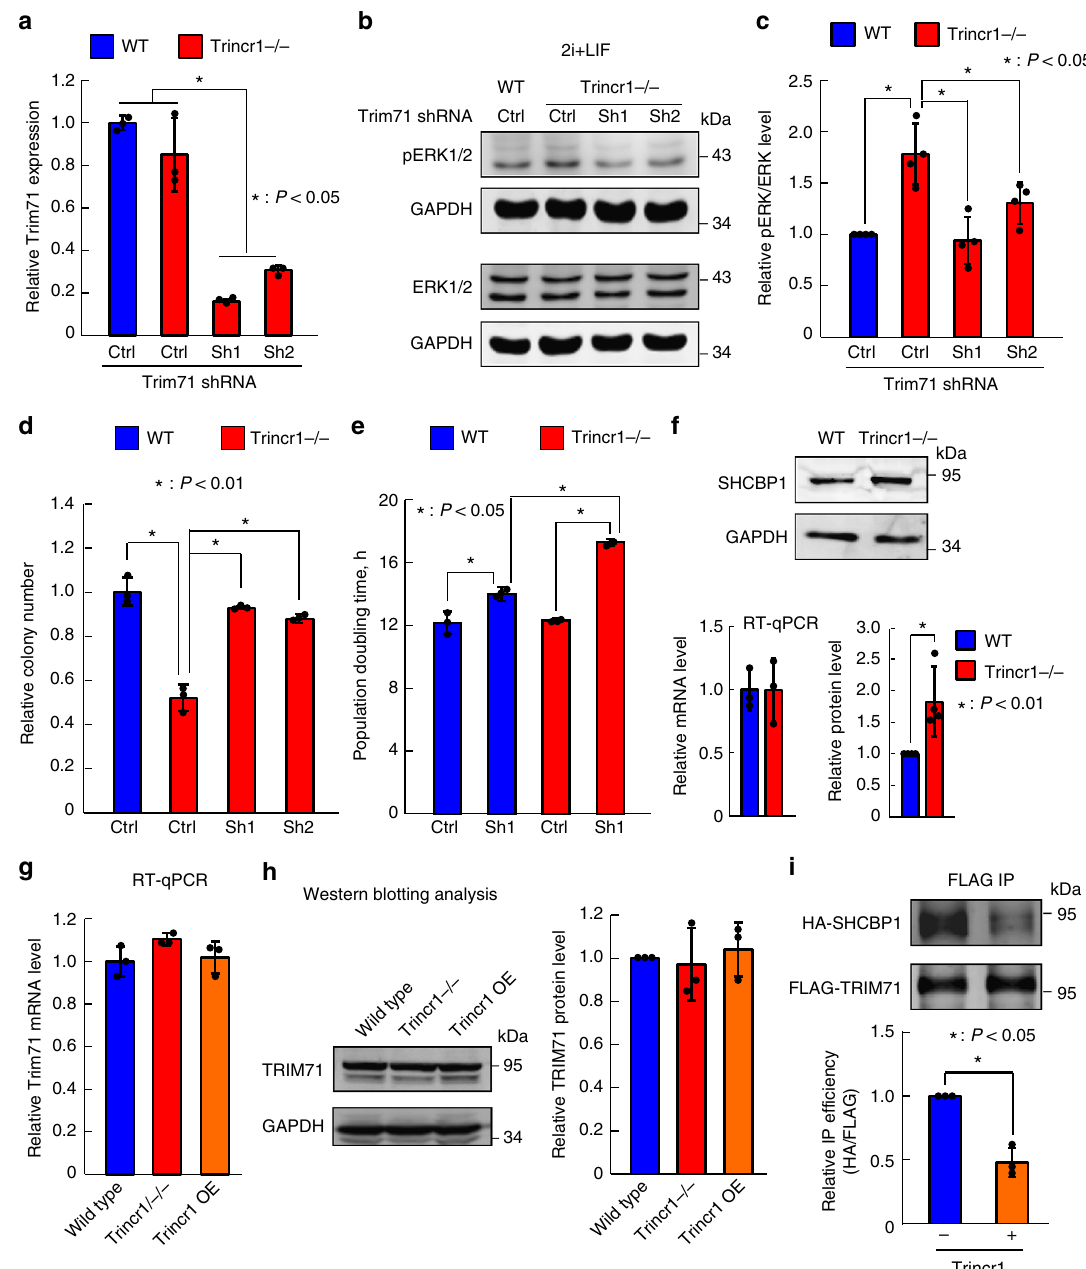
Fig. 6 Trincr1 functions through suppressing TRIM71. a RT-qPCR analysis of Trim71 knocking down in Trincr1 − / − ESCs. n = 3 biological replicates. b Western blotting analysis of pERK in control shRNA vector treated wild-type ESCs and control or Trim71 shRNA vector treated Trincr1 − / − ESCs cultured in 2i + LIF. Shown are representative images. c Quanti fi cation of pERK/ERK. n = 4 independent experiments. d Colony formation assay for control or Trim71 shRNA ESCs in wild type or Trincr1 − / − in PD + LIF. n = 3 biological replicates. e Population doubling time for Trincr1 − / − and Trim71 knockdown ESCs in 2i + LIF medium. n = 3 biological replicates. The fi rst two columns were the same data appeared in Supplementary fi gure 1e. f Western blotting analysis and qPCR of Shcbp1 in wild type and Trincr1 − / − ESCs. Bottom left: quanti fi cation of western blot data, n = 4 independent experiments. Bottom right: qPCR of Shcbp1. Data were normalized to wild-type ESCs. n = 3 biological replicates. g RT-qPCR analysis of Trim71 expression in wild type, Trincr1 − / − , and Trincr1_S overexpressing ESCs. Data were normalized to wild-type ESCs. n = 3 biological replicates. h Western blotting analysis of FLAG knockin TRIM71 in wild type, Trincr1 − / − , and Trincr1_S overexpressing ESCs in 2i + LIF. n = 3 independent experiments. i Western blotting analysis of immunoprecipitation with FLAG antibody (FLAG IP) in HEK293 cells expressing HA-SHCBP1 and FLAG-TRIM71 with or without Trincr1_S overexpression. Shown are representative images of IP samples (left) and quanti fi cation of IP ef fi ciency (right). IP ef fi ciency was calculated as HA-SHCBP1 /FLAG-TRIM71 and then normalized to samples without Trincr1_S overexpression. n = 3 independent experiments. For the RT-qPCR of a , f , and g , the β -actin gene was used as a control. Shown are mean ± SD. For a , c , and d , data were normalized to wild-type ESCs treated with control shRNA vectors, P values were determined by unpaired one-way ANOVA with two-sided Dunnett ’ s test. For e , P- values were determined by unpaired two-way ANOVA with Tukey ’ s test. For f and i , P values were determined by paired two-sided Student ’ s t